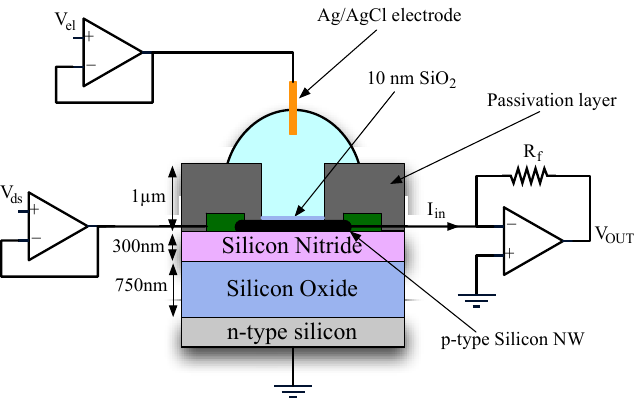
Figure 4. Typical experimental setup with the buffer potential fixed with a liquid gating electrode and substrate connected to ground. A stimulus voltage is applied at the source and a current read by a transimpedance amplifier at the drain.